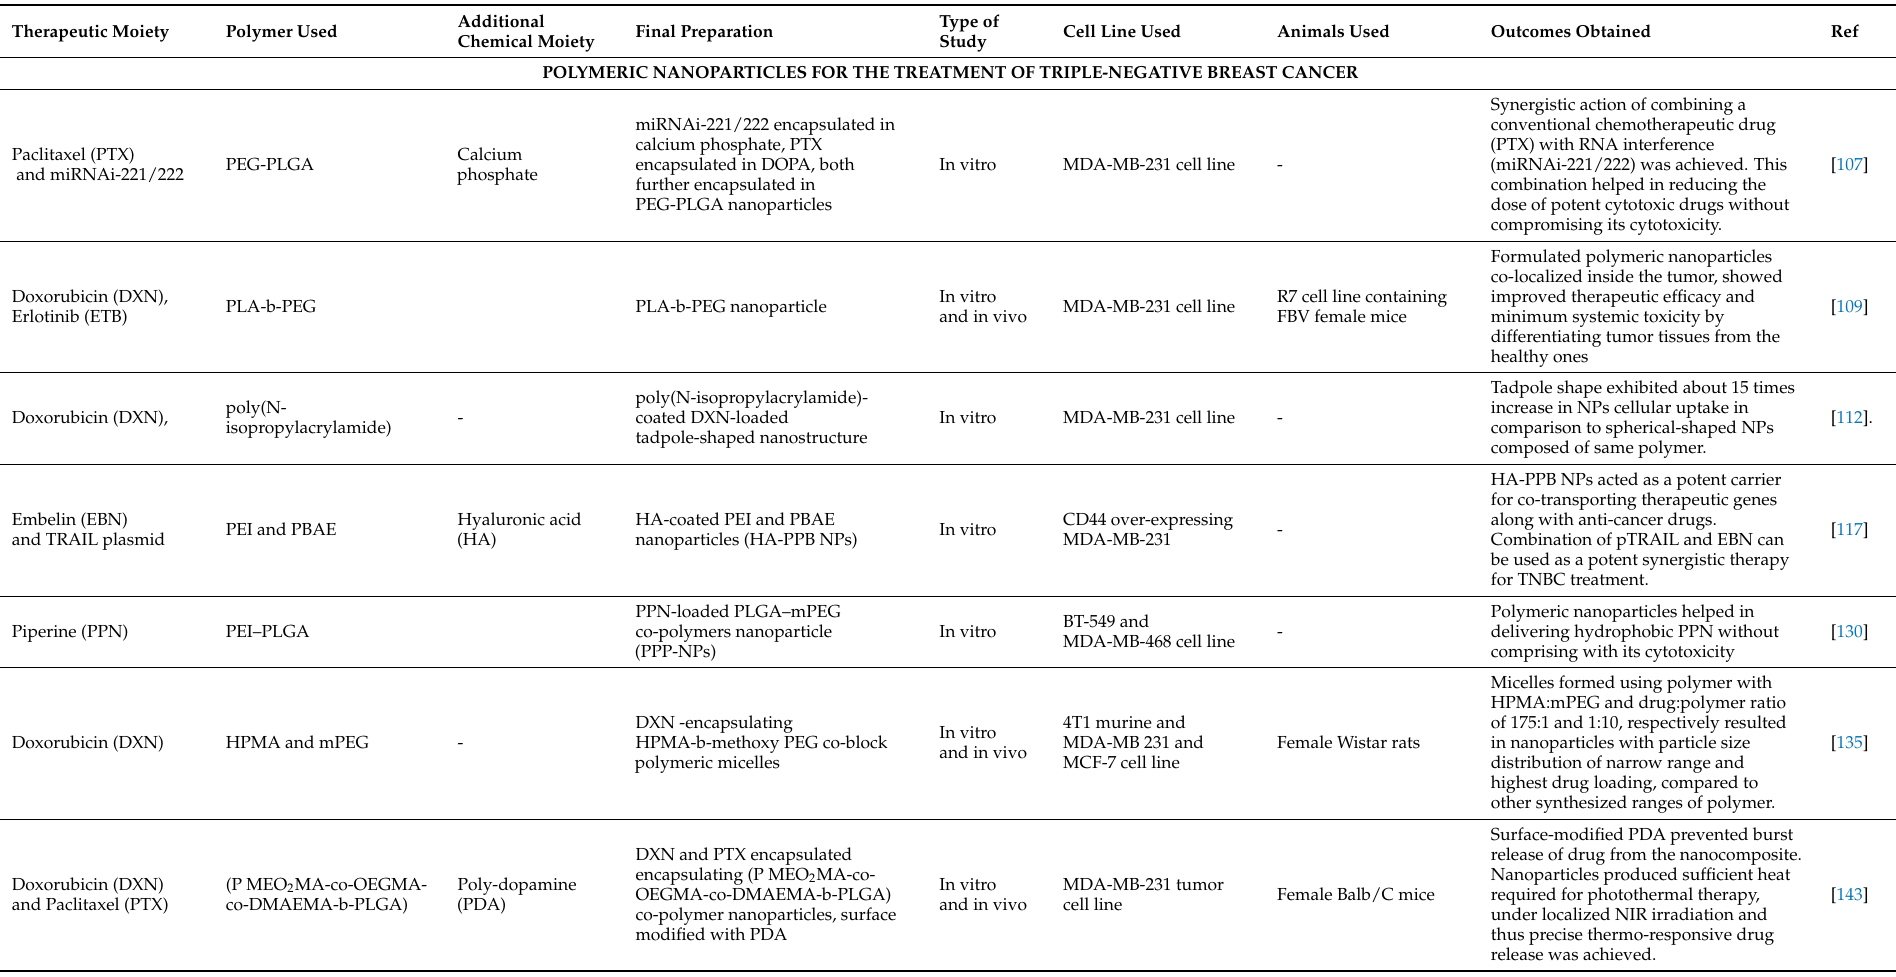
Table 1. Research work conducted on the tumor targeting ability of different polymeric nanocarriers in complex with different chemotherapeutic